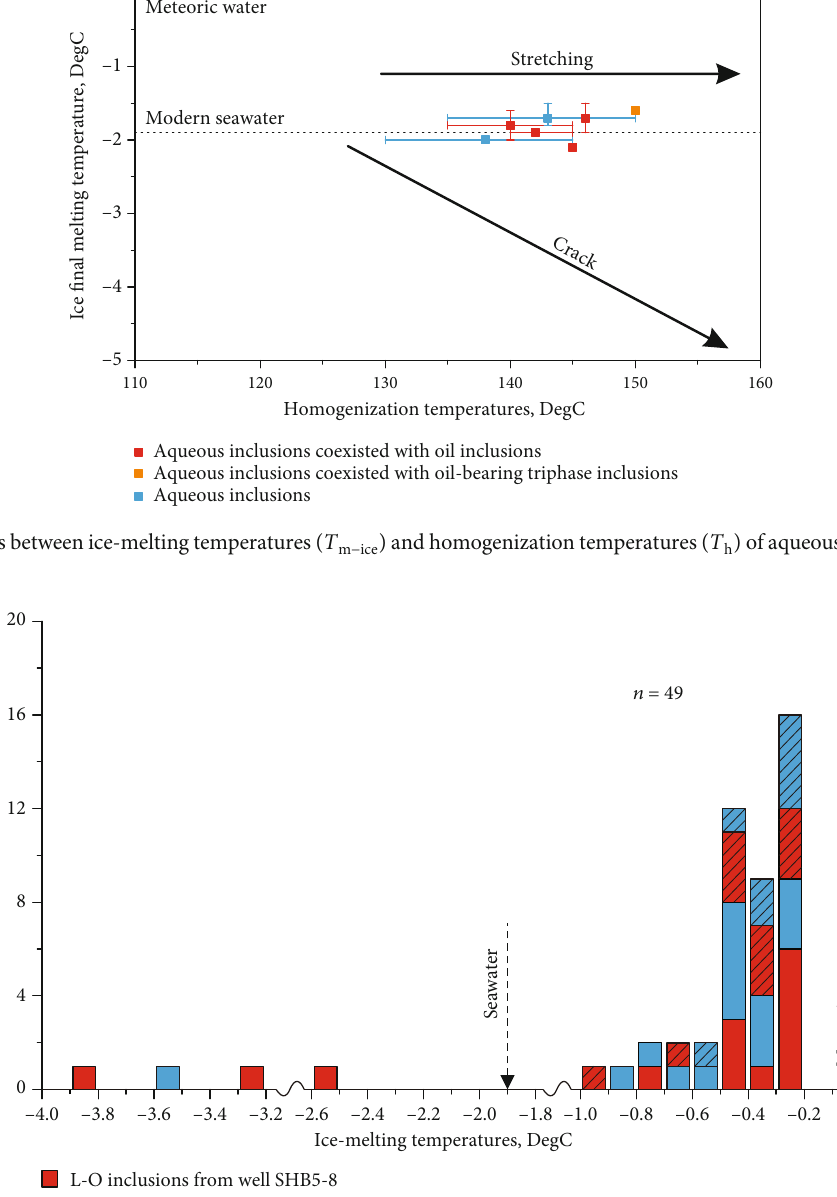
Figure 7: Histograms of ice-melting temperatures of fl uid inclusions in CT5 and